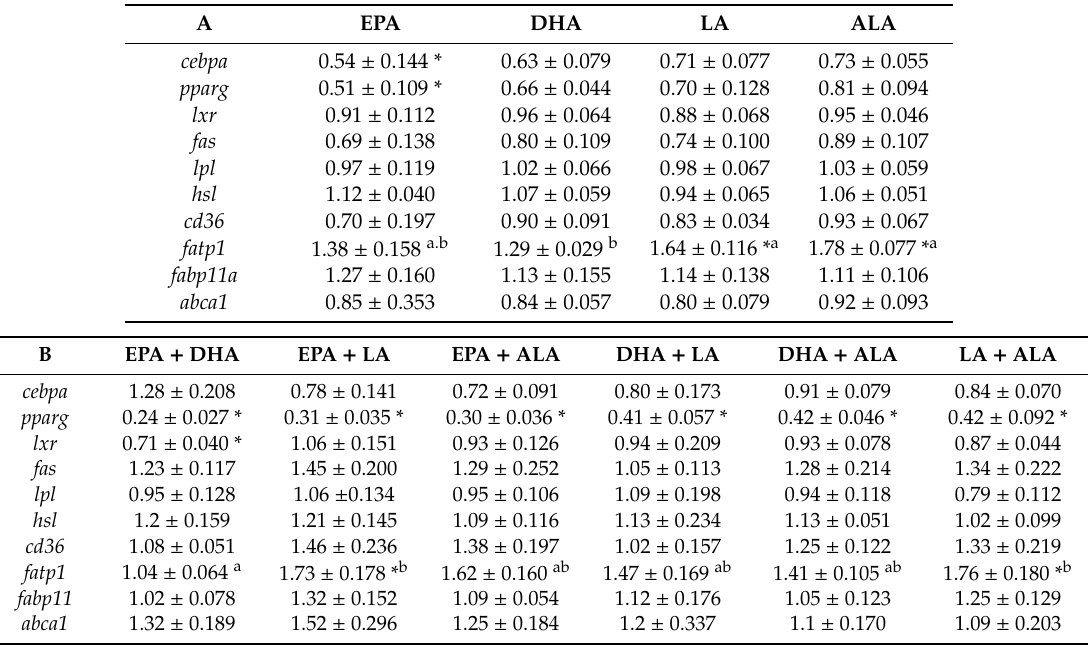
Table 1. Relative expression of transcription factors ( cebpa , pparg , and lxr ), lipid metabolism-related genes ( fas , lpl , and hsl ) and lipid transporters ( cd36 , fatp1 , fabp11 , and abca1 ) normalized to ef1a and ub in rainbow trout preadipocyte cells. Cells at day 7 were treated with di ff erent ( A ) individual or ( B ) combined fatty acids or were left untreated as control for 6 h. Data are expressed relative to control (value = 1) and shown as mean + SEM ( n = 4–6). Significant di ff erences ( p < 0.05) with the control are indicated by asterisks (*) and among treatments by di ff erent letters ( a,b ). EPA: eicosapentaenoic